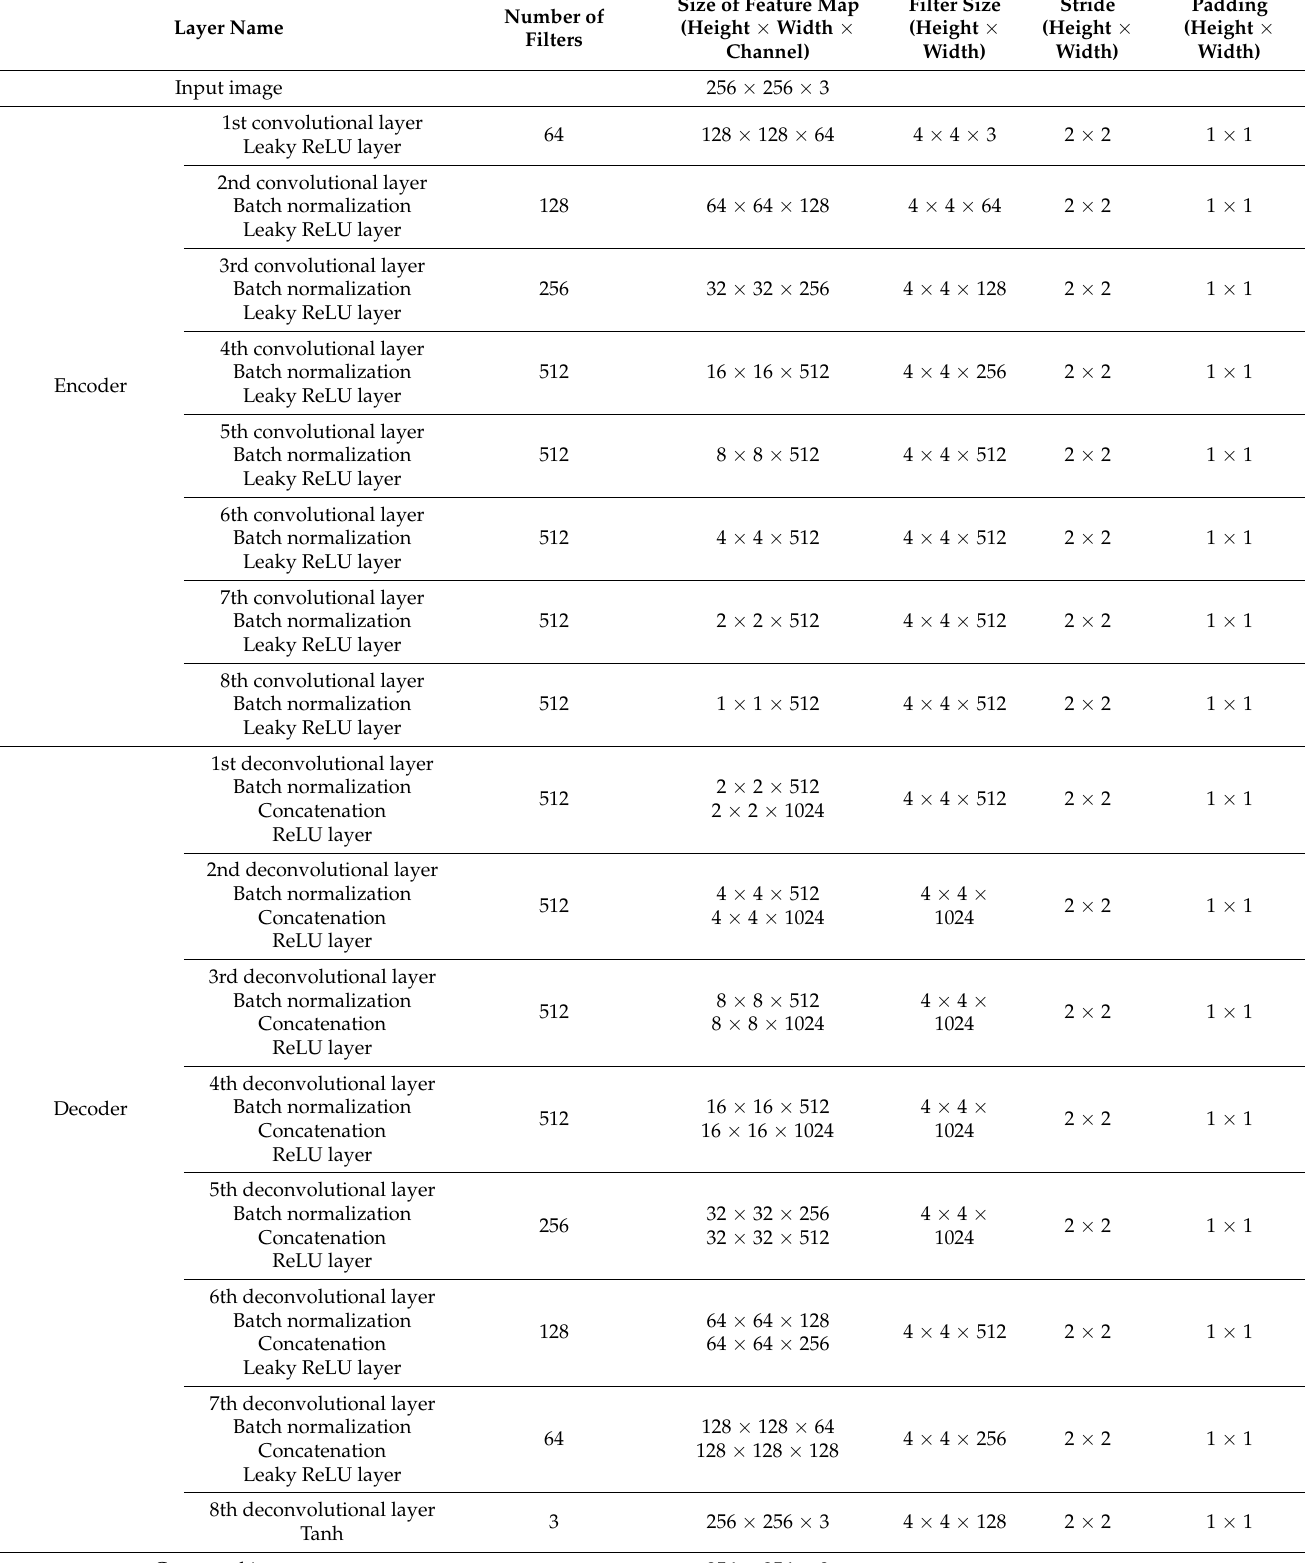
Table 3. Generator structure using U-net in